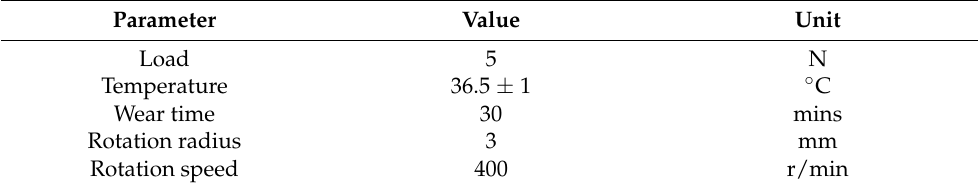
Table 4. Experimental parameters of the wear